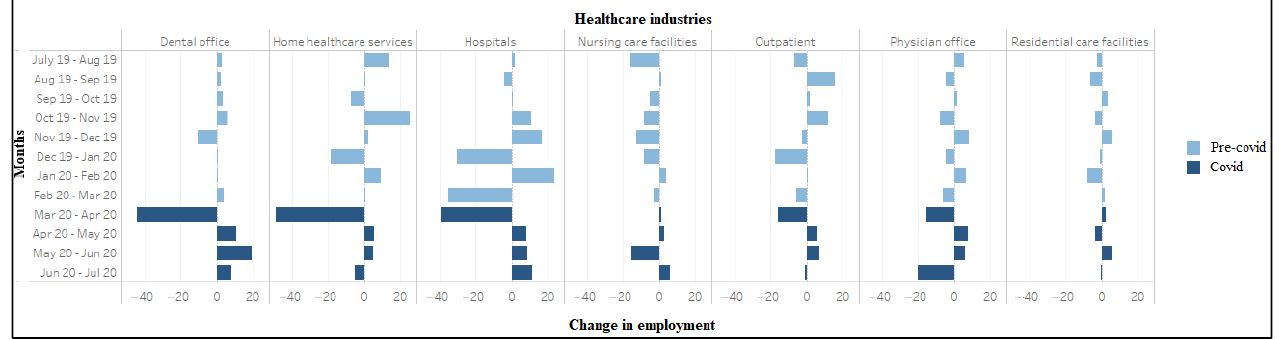
Figure 3. Change in employment (in ten thousand) among workers in healthcare industries (July 2019–2020). Int. J. Environ. Res. Public Health 2021 , 18 , x FOR PEER REVIEW